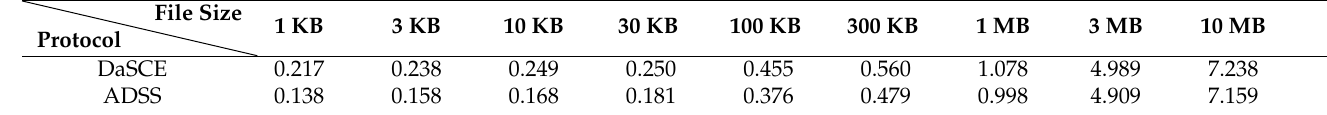
Table 2. Time cost of ADSS and DaSCE protocols in file upload stage.